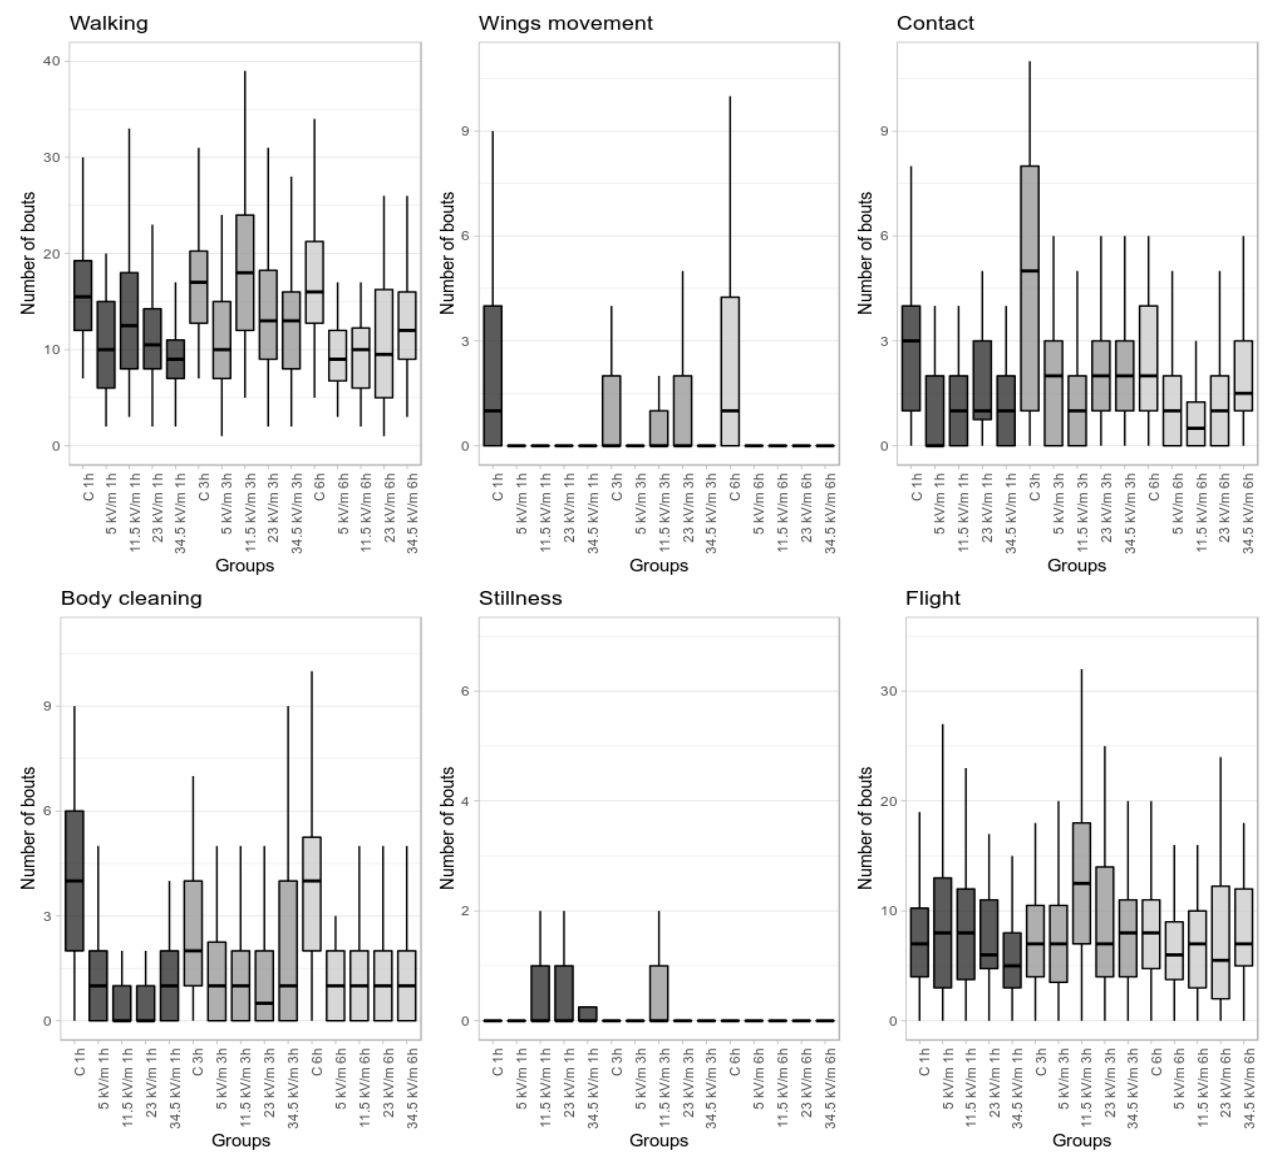
Figure 1. Comparison of the mean number of bouts as a function of exposition time and E-field intensity in and between all groups. The median values are marked by a horizontal line. The lower and upper whiskers denote the minimum and maximum values, respectively.